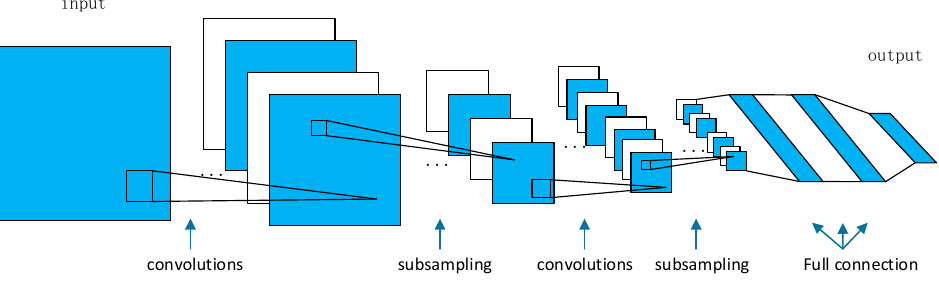
Figure 1. The architecture of LeNet.